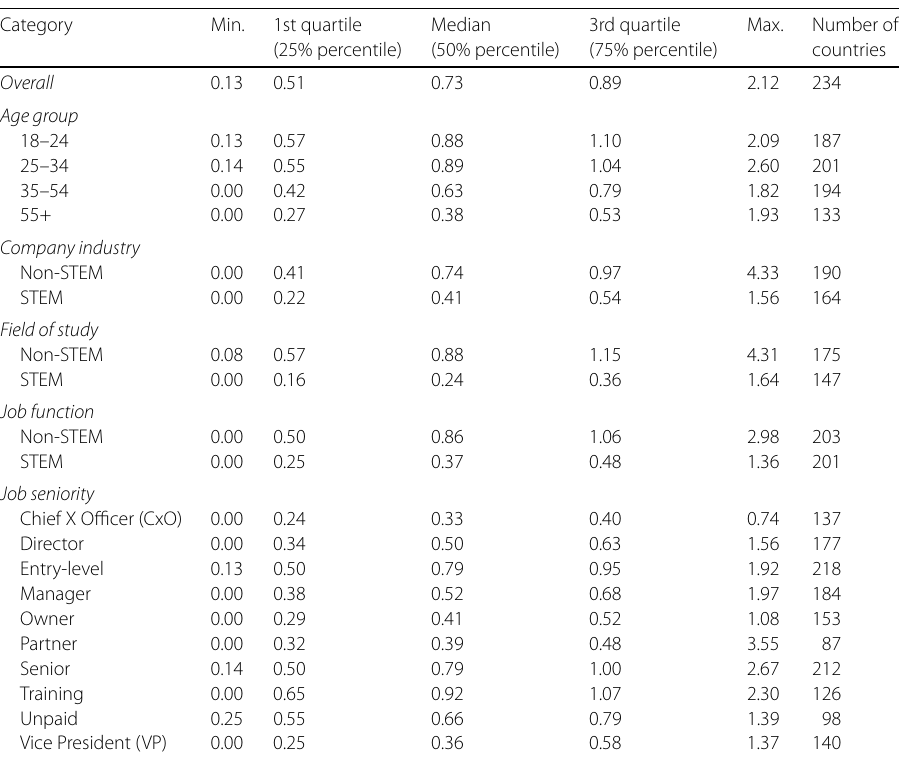
Table 2 Summary statistics of LinkedIn Gender Gap Indices (GGI) by different characteristics (as displayed in Fig. 2)